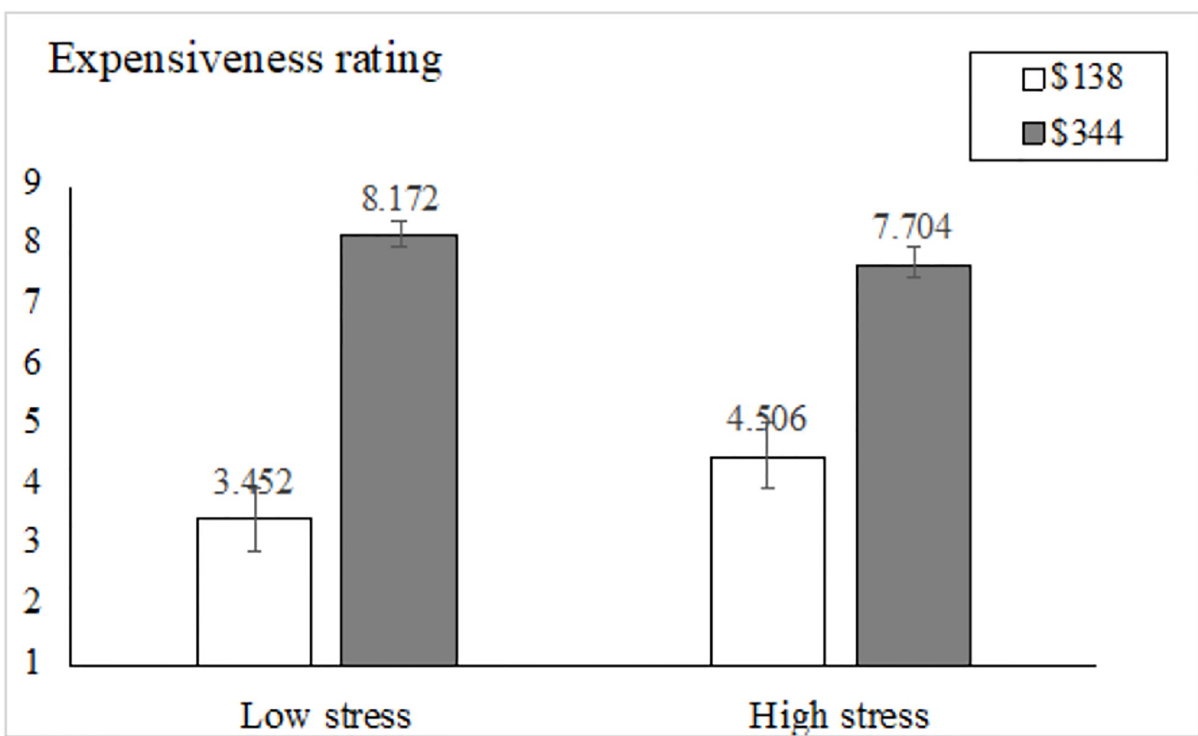
Fig 1. Stress and scope sensitivity in hotel room price